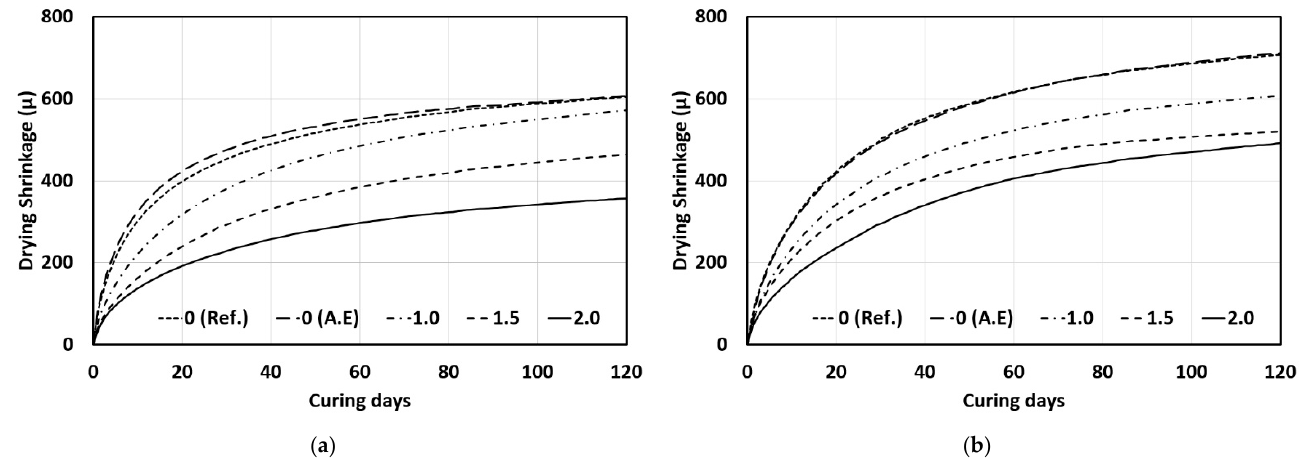
Figure 11. Results of drying shrinkage: ( a ) Water-cement ratio 40%; ( b ) Water-cement ratio 50%.